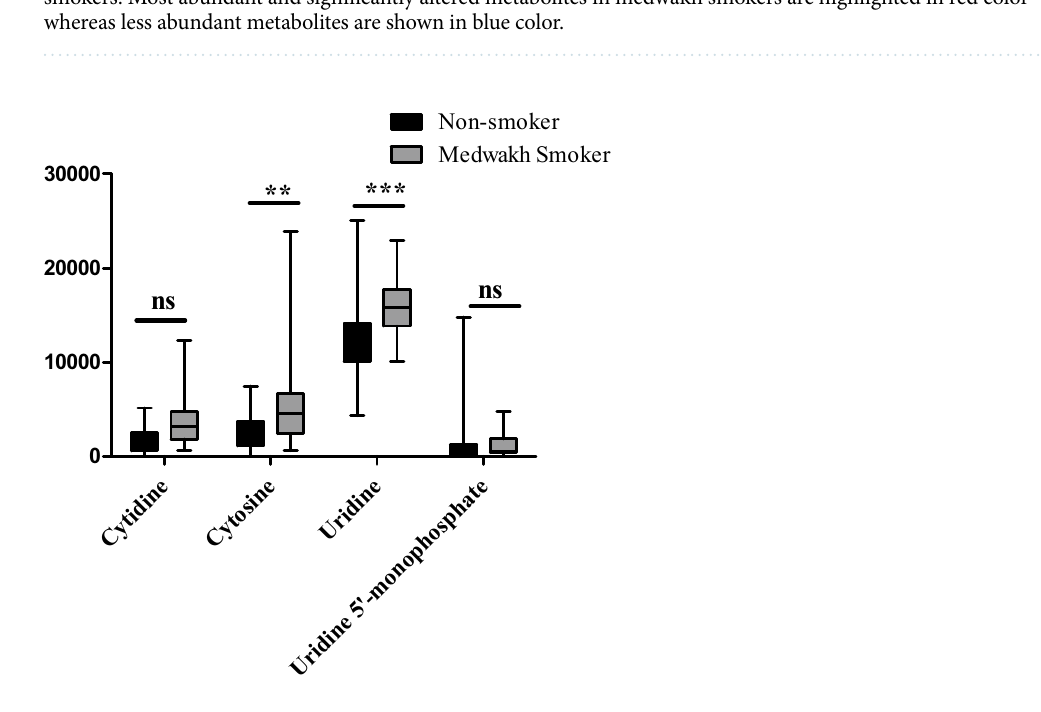
Figure 4. Differential salivary metabolites of top enriched pyrimidine pathway derived from the comparison between medwakh smokers and non-smoking controls. A higher fold-change was observed in the saliva of medwakh smokers for cytidine, cytosine, uridine and uridine 5’-monophosphate. Two-way analysis of variance (ANOVA) and post hoc Bonferroni multiple comparison analyses was applied to compare more than two independent variables. Samples included 30 medwakh and 30 non-smoking controls. ** p < 0.01, * ** p < 0.001 is indicated. ns—not significant. Results are presented as median ±